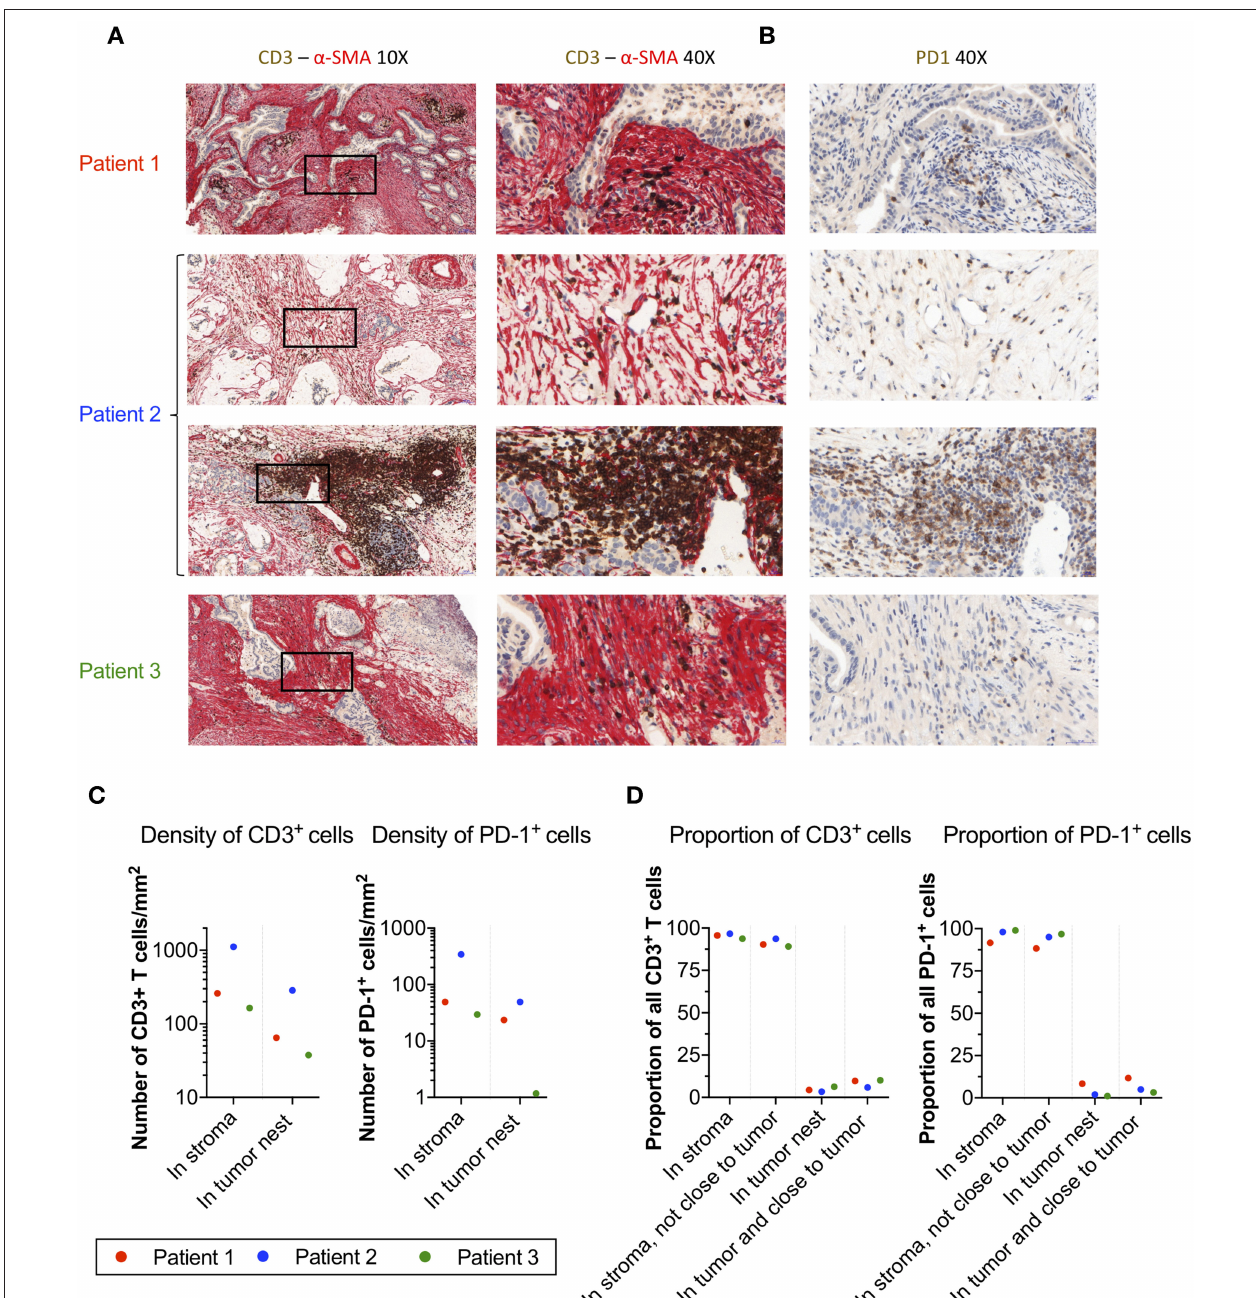
FIGURE 4 | Localization of T-cells and PD-1 + cells in α -SMA + desmoplastic tumor stroma. (A) Microphotographs of representative tumor areas from three different patients showing abundant desmoplastic stroma composed of α -SMA + CAFs (red) with foci of CD3 + T-cells (brown). In these three patients, most of the T-cells were localized in the stroma with little direct cell-cell contact with adjacent adenocarcinoma cells. Second row of sample from patient 2 (a patient with colloid carcinoma of the pancreas) illustrates a peritumoral tertiary lymphoid structure. (B) Consecutive slides stained for PD-1 (brown) show abundant expression of PD-1 in T-cell rich areas within the desmoplastic stromal compartment. (C) Number of CD3 + T-cells and PD-1 + cells per mm 2 in stroma and tumor nests in 4 annotations. (D) Percentage of CD3 + and PD-1 + cells detected in the stroma, in the stroma without close interaction with the tumor (20 µ m), in the tumor nest, and in the tumor nest including positive cells in close proximity to the tumor (20 µ